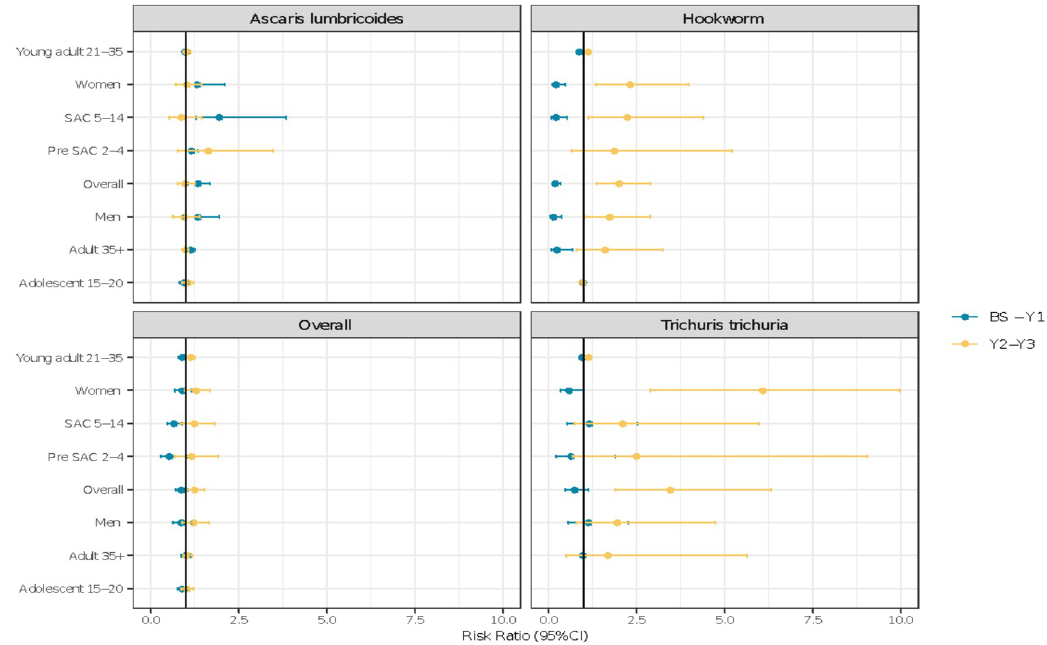
Fig 3. Risk ratios of STH reinfection between surveys. Blue = BS–Y1 reinfection (survey 1 to survey 2). Yellow = Y1 –Y2 reinfection (survey 2 to survey 3. Horizontal lines represent 95% confidence